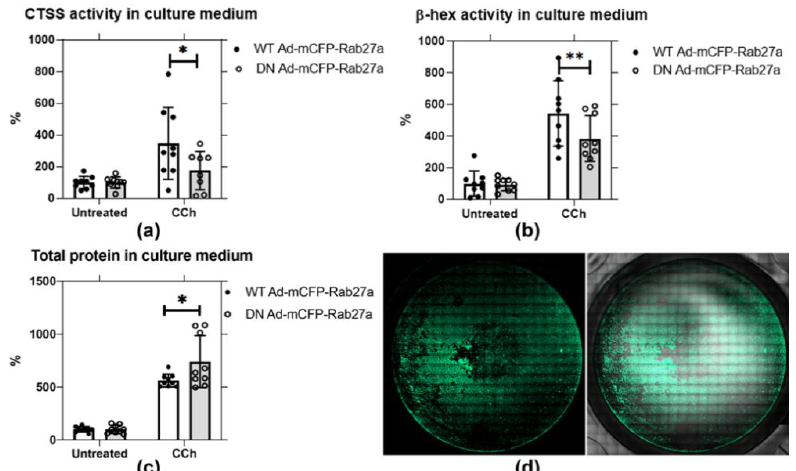
Figure 5. DN Ad-mCFP-Rab27a transduction significantly reduces CTSS and β -hex secretion in primary cultured rabbit LGACs. Secretion assays were conducted in primary rabbit LGACs transduced with adenovirus encoding either mCFP- tagged WT or DN Rab27a Ad at a MOI of 4–6. CTSS and β -hex activity, as well as total protein in cell culture medium were normalized to protein in cell lysate. ( a ) CTSS activity secreted into culture medium with CCh stimulation (100 µ M) was significantly reduced by half in cells transduced with the DN mCFP-Rab27a compared to WT Rab27a. *, p = 0.0120 ( b ) β -hex activity in culture medium was also significantly reduced by expression of DN mCFP-Rab27a relative to WT mCFP-Rab27a. **, p = 0.0020. ( c ) Total protein secreted in response to CCh was significantly increased with DN mCFP-Rab27a relative to WT Rab27a expression. *, p = 0.0271. ( d ) LGAC transduction was ~40–50% efficiency, as shown by the representative image for cells transduced with WT mCFP-Rab27a, detailed in Figure S2. N = 3, N= cell preparation. Two to three replicate measurements per preparation, represented as points on the graph, mean ±